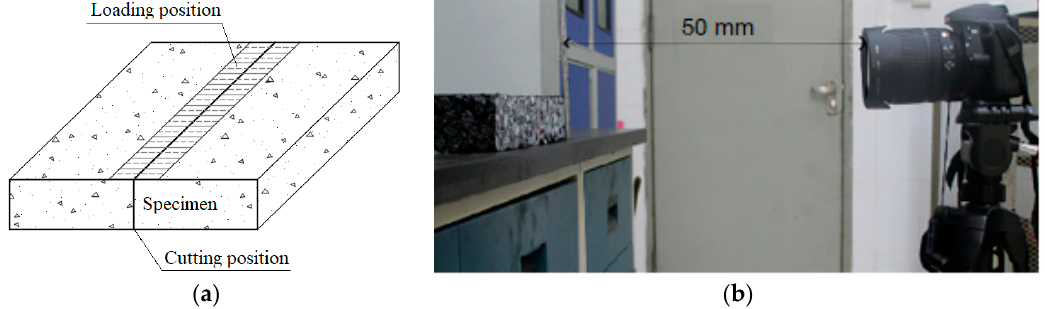
Figure 3. Specimen cutting and image acquisition methods. ( a ) Specimen cutting; and ( b ) image Figure3. Specimencuttingandimageacquisitionmethods. ( a )Specimencutting; and( b )imageacquisition. acquisition.